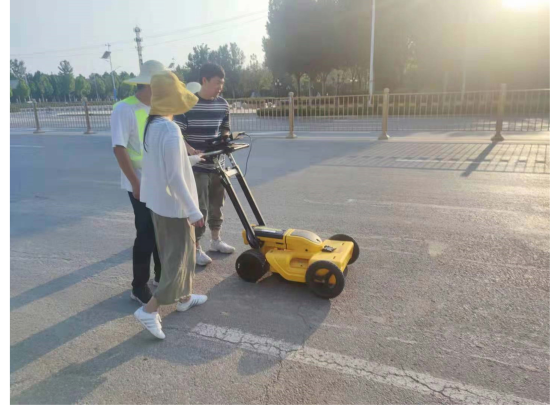
Figure 15. A photo of the collection of measurements.